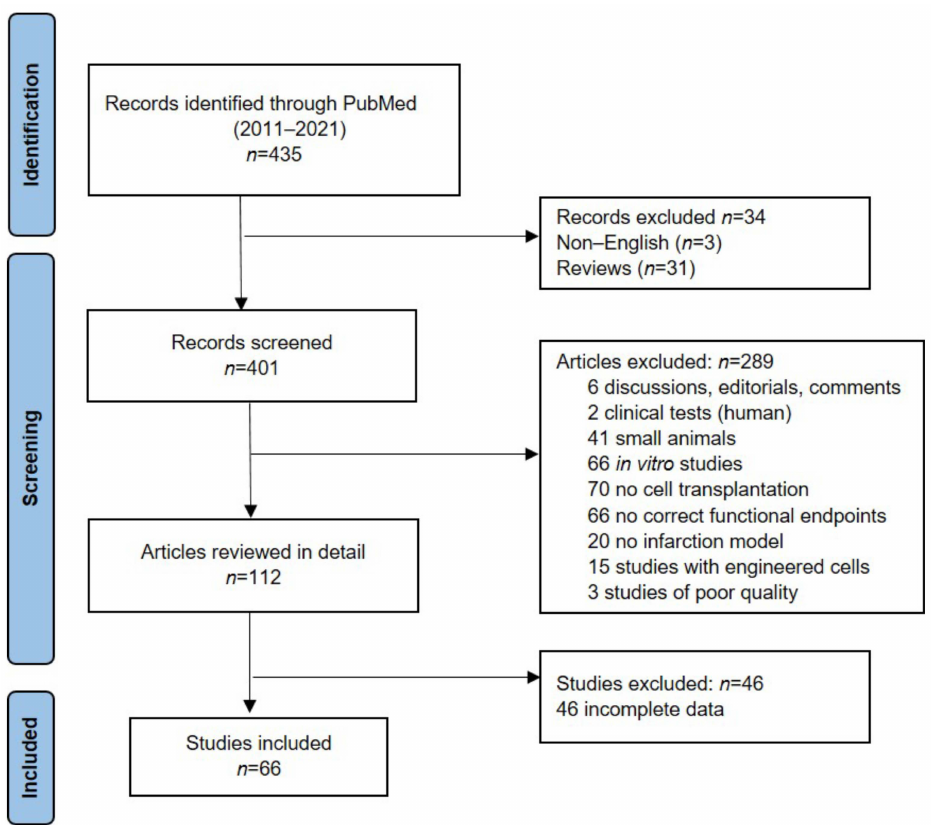
Figure 1. PRISMA workflow of the study selection process, records screened and studies